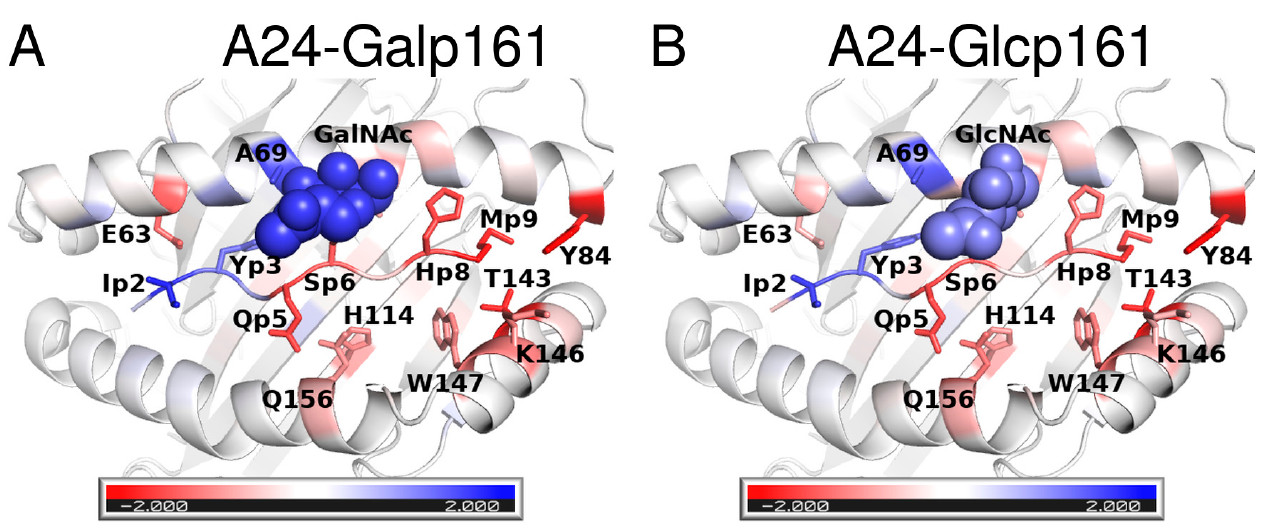
Figure 4. Differences in contributions of the peptide residues to the total interaction energies with A24. The difference is between the interactions of p161 and those of the glycosylated peptides, namely ( A ) Galp161 and ( B ) A24-Glcp161. The colors correspond to energies ranging from − 2 kcal mol − 1 to 2 kcal mol − 1 where red indicates that p161 residues are more stabilizing, while blue indicates that p161 residues are destabilizing. Residues that undergo large differences upon glycosylation are shown in sticks. GalNAc and GlcNAc are shown in spheres.